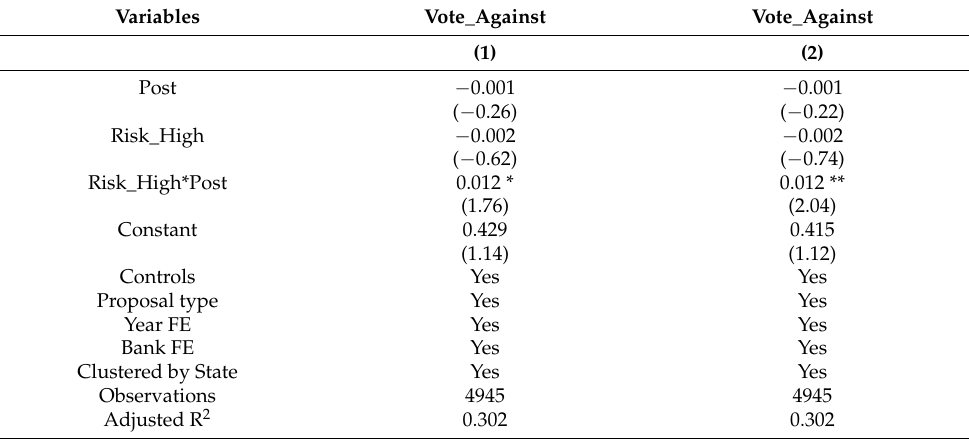
Table 4. The role of bank risk on shareholders’ response to market competition.